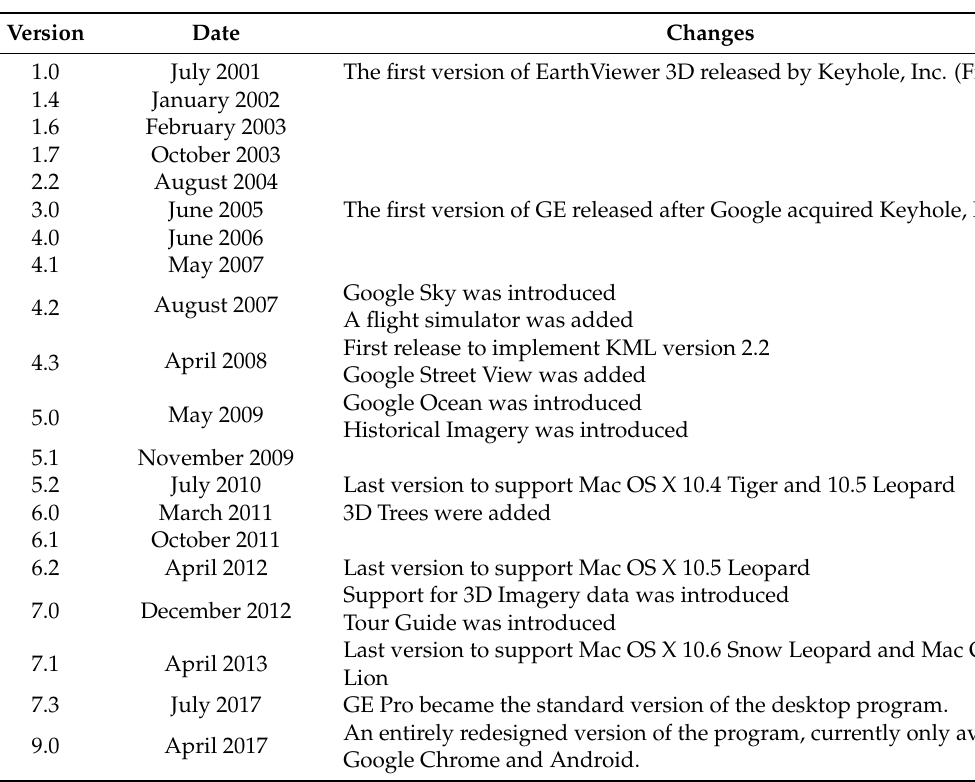
Table 1. The version history of Google Earth (GE)